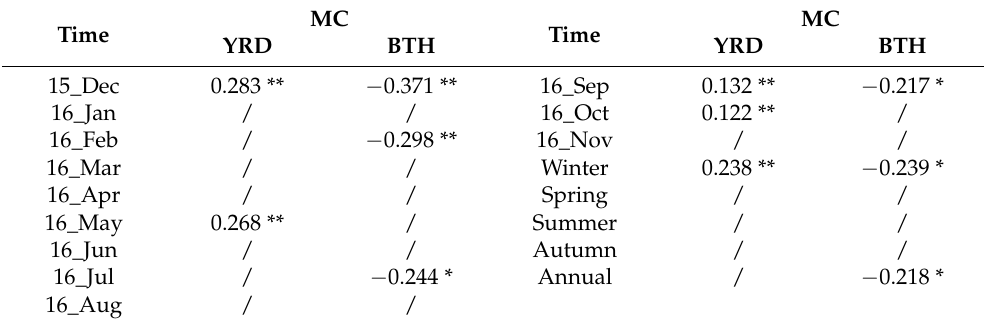
Table 4. The MCs for residuals of the GLR model at monthly, seasonal, and annual time scales. Time